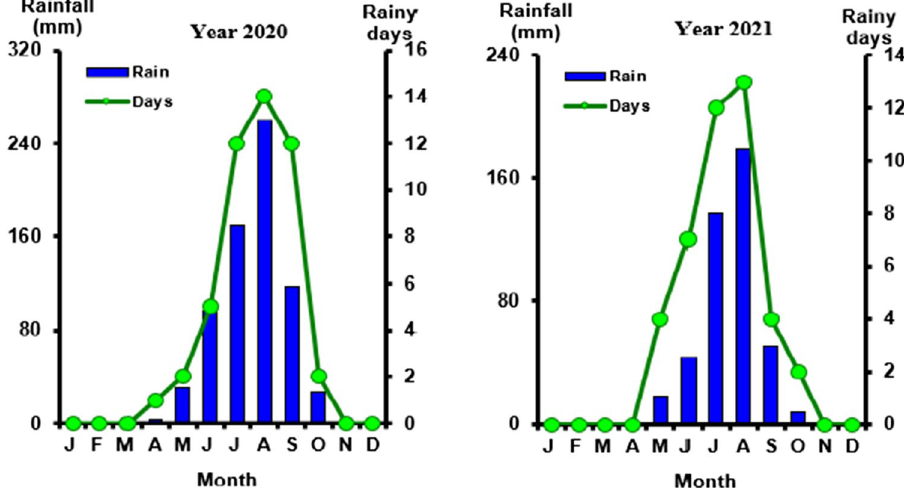
Fig. 1 Monthly rainfall distri- butions for 2020 and